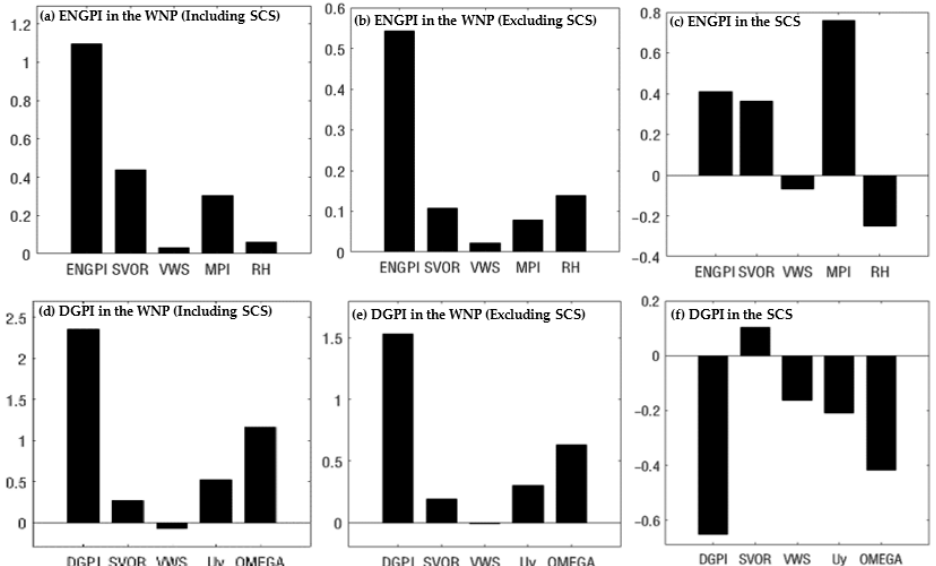
Figure 6. Differences of the GPI (November 2019 minus the climatological mean) and varying variables over different sea areas: total ENGPI anomaly and the ENGPI anomaly varying absolute vorticity (SVOR), vertical wind shear (VWS), maximum potential intensity ( MPI ), and 600 hPa relative humidity (RH) in the WNP (including SCS) ( a ), the WNP (excluding SCS) ( b ), and the SCS ( c ); Total DGPI anomaly and the DGPI anomaly varying absolute vorticity (SVOR), vertical wind shear (VWS), meridional gradient of zonal wind (Uy), and vertical velocity (OMEGA) in the WNP (including SCS) ( d ), the WNP (excluding SCS) ( e ), and the SCS ( f ).